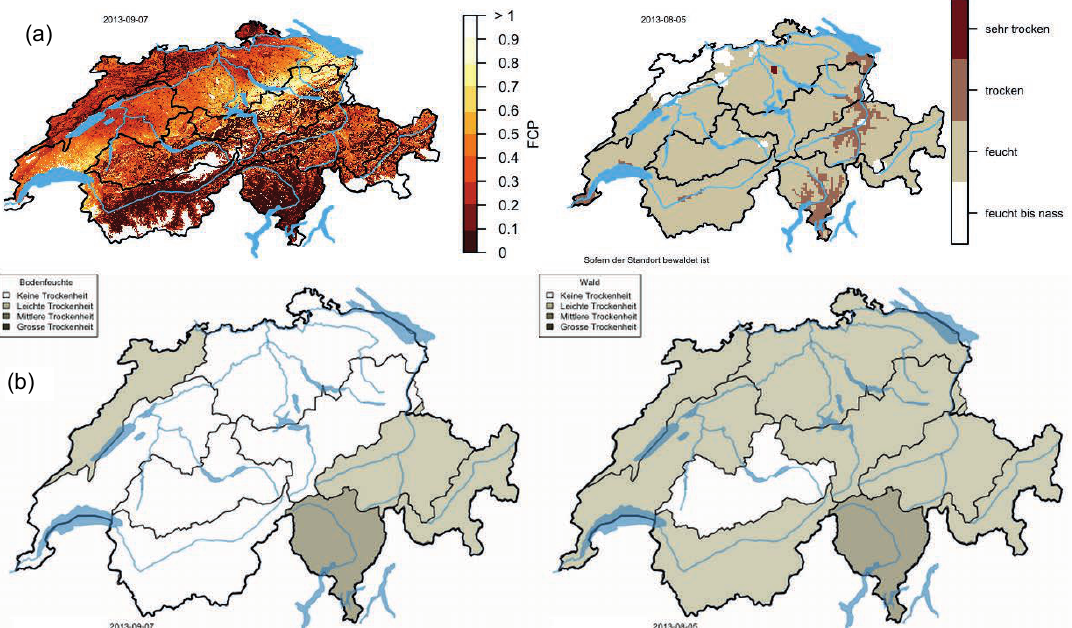
Fig. 2 Operational monitoring of drought indicators (a) and corresponding awareness maps (b). Left panels: simulated soil saturation (FCP) on 7 September 2013. Right panels: indication of dryness in forests on 5 August 2013. The grey scale in the awareness maps ranges from “no drought” (“Keine Trockenheit”, white) to “light” (“Leichte”), “moderate” (“Mittlere”) and “severe drought” (“Grosse Trockenheit”, dark